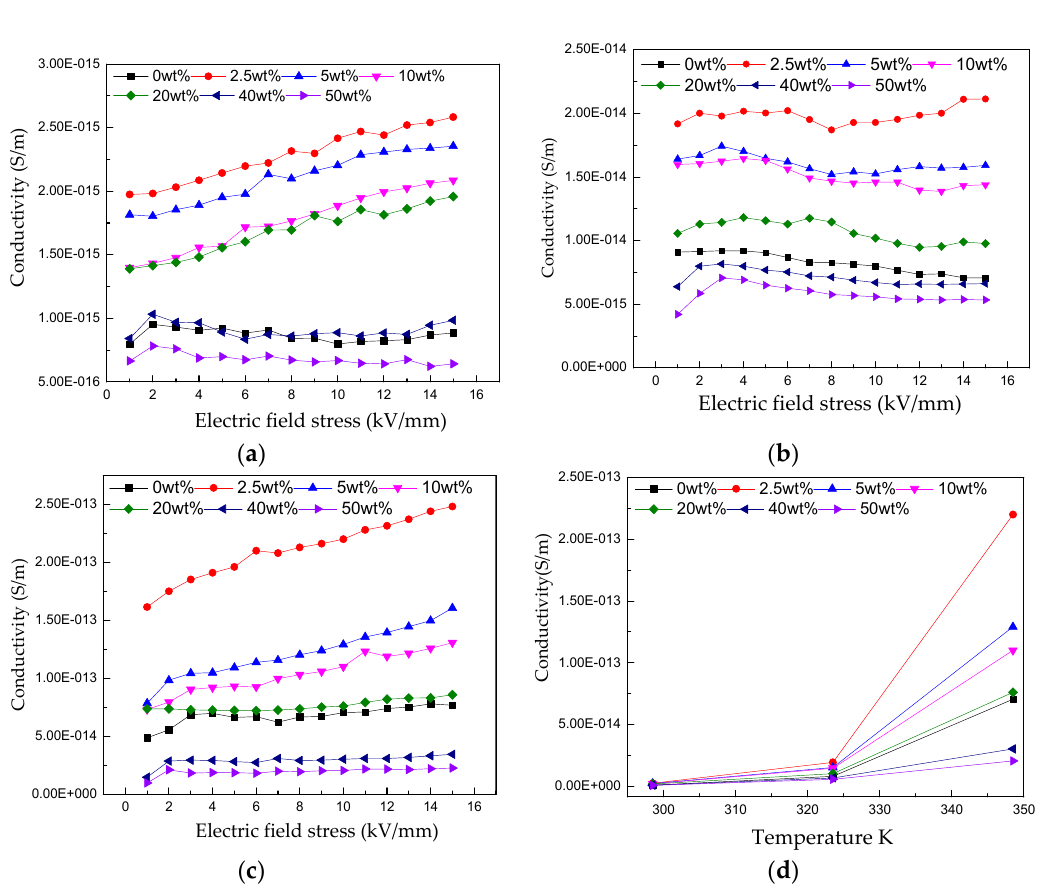
Figure 6. ( a ), ( b ) and ( c ) are respectively the DC conductivity versus E curves of RIP with different h-BN nano-flakes components at 298.15, 323.15 and 348.15 K; ( d ) is DC conductivity versus temperature of RIP with different h-BN nano-flakes components at 10 kV/mm.